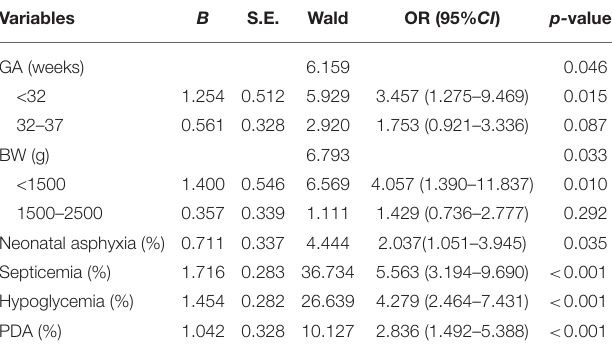
TABLE 2 | Multivariate regression analysis of significant risk